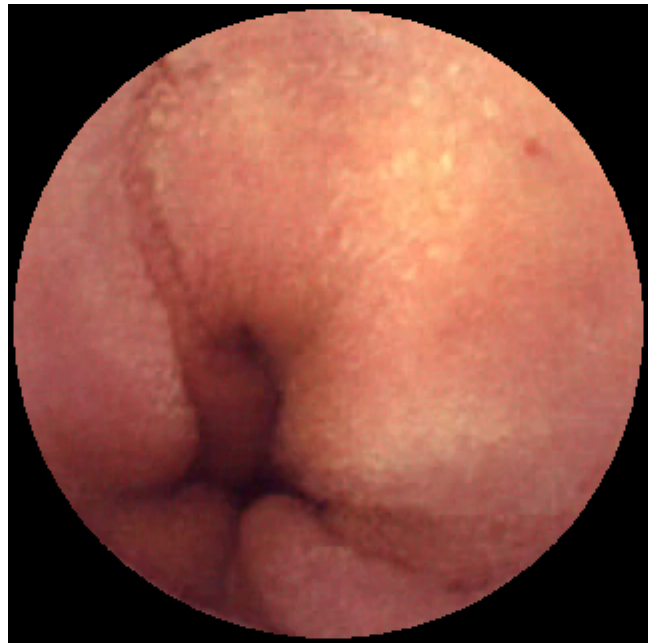
Figure 2. KID video 1 frame after